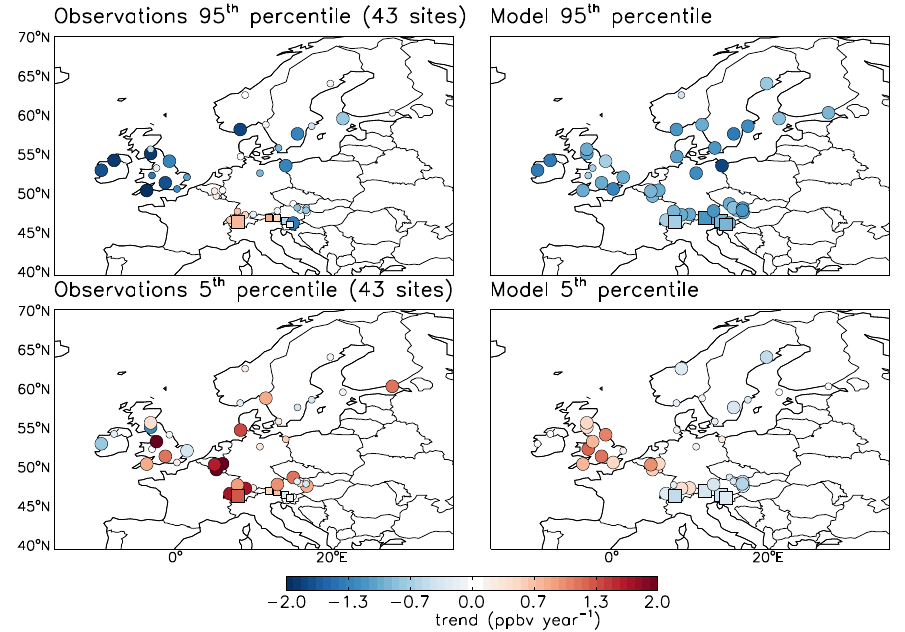
Fig. 3. Trends (%yr − 1 ) in the 95th (top) and 5th (bottom) percentile of the distribution of the 8-h daily maximum summertime O 3 concentrations at 43 European stations for the observations (left) and the model (right). The simulated trends (right panels) are computed using the hourly model O 3 values from the control simulation (“S0”). Circles and squares denote trends at sites above and below 1500m, respectively. Large symbols denote significant trends at the 0.05 level. Small symbols denote trends that are not statistically significant.